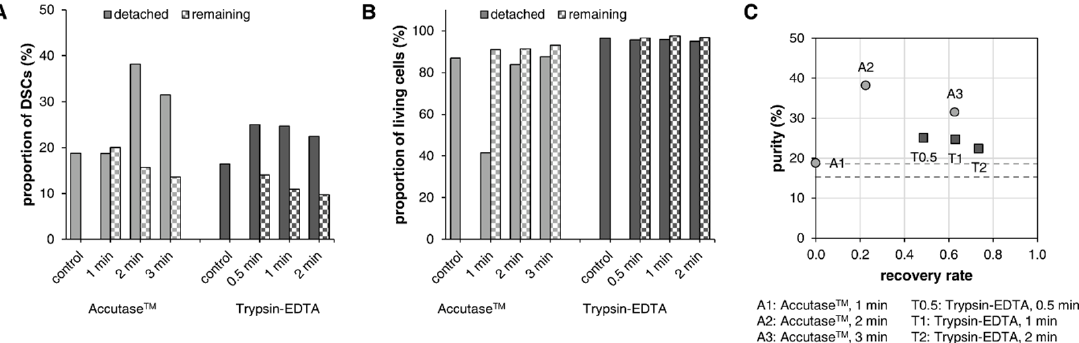
Figure 3. Selective detachment of DSC-fibroblast co-cultures with 10–20% stem cells. Dermal cells were incubated with Accutase™ for 1, 2, or 3 min or with trypsin-EDTA for 0.5, 1, or 2 min, and detached cells were collected. ( A ) Frequency of DSCs in samples measured using NGFRp75 staining. ( B ) Viability of total cells examined with propidium iodide. ( C ) Plot of recovery rate ( x -axis) versus purity ( y -axis) of detached cells at the individual incubation times. Purity: frequency of DSCs. Recovery rate: ratio of the absolute number of DSCs in the detached sample to the absolute number of DSCs before detachment. Dotted lines indicate the DSC frequency of control cells detached with Accutase™ (light gray) or trypsin ‐ EDTA (dark gray). Results from one representative donor cell strain.